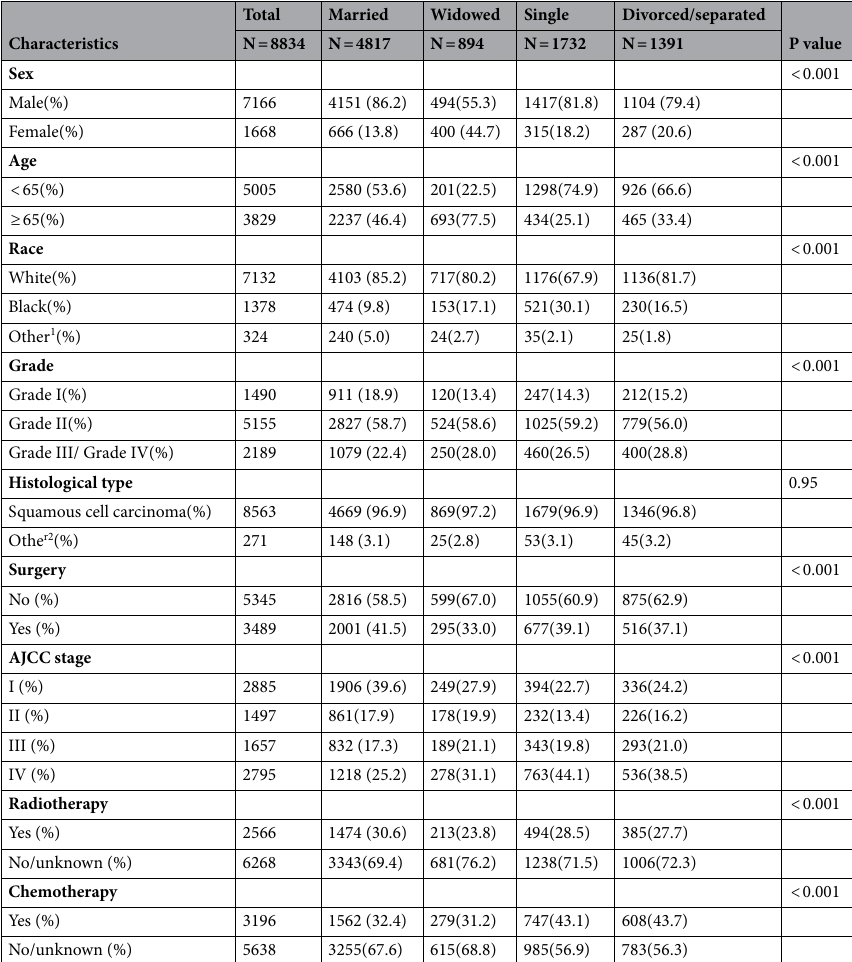
Table 1. Baseline clinicopathological characteristics of patients. Other 1 (Asian or Pacific Islander, American Indian/Alaska Native). Other 2 (Neoplasm, malignant; Carcinoma, NOS; Carcinoma, undifferentiated, NOS; Large cell carcinoma, NOS; Large cell neuroendocrine carcinoma; Spindle cell carcinoma, NOS; Pseudosarcomatous carcinoma; Carcinoma, anaplastic, NOS; Non-small cell carcinoma; Small cell carcinoma, NOS; Papillary squamous cell carcinoma; Verrucous carcinoma, NOS; Combined small cell carcinoma; Papillary carcinoma, NOS; Basaloid squamous cell carcinoma; Lymphoepithelial carcinoma; Basaloid carcinoma; Adenocarcinoma, NOS; Scirrhous adenocarcinoma; Adenoid cystic carcinoma; Neuroendocrine carcinoma, NOS; Mucoepidermoid carcinoma; Papillary carcinoma, follicular variant; Adenosquamous carcinoma; Adenocarcinoma with cartilaginous and osseous metaplasia; Adenocarcinoma with neuroendocrine differentiation; Carcinoma in pleomorphic